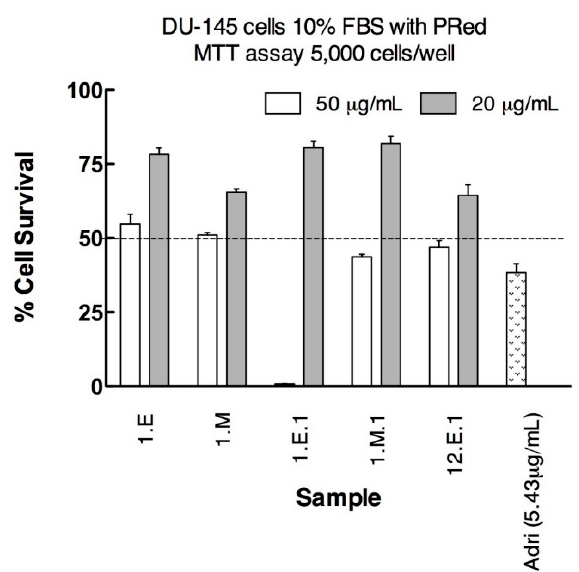
Figure 2. Cell survival of a cytotoxic assay against DU-145 prostate cancer cell line of different samples tested at two concentrations (20 µg/mL and 50 µg/mL). Adriamycin at 5.43 µg/mL was used as